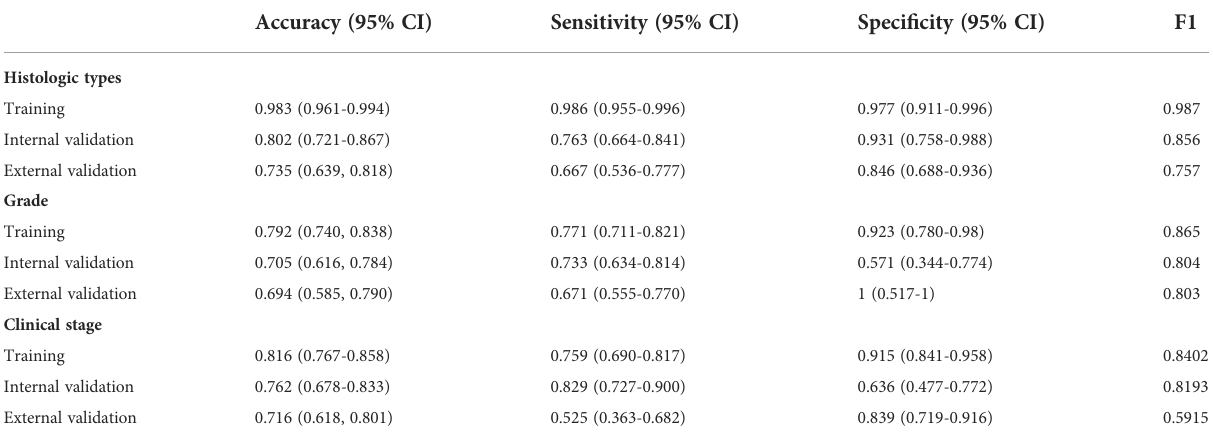
TABLE 2 Performance for XGBoost